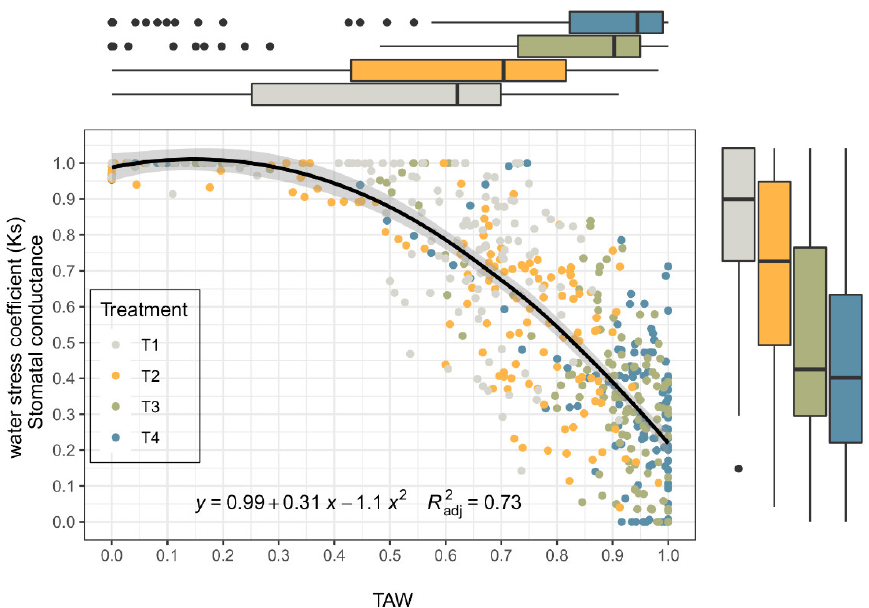
Figure 8. Relationship between stress coefficients ( Ks ) for stomatal conductance ( gs ) and relative availability of soil water during a stress cycle ryegrass ( Lolium perenne ). Treatment are color coded. T1: moderate–low water stress treatment (grey color), T2: moderate–high water stress treatment (yellow color), T3: medium intensity severe water stress treatment (green color), T4: high intensity severe water stress treatment (blue color).